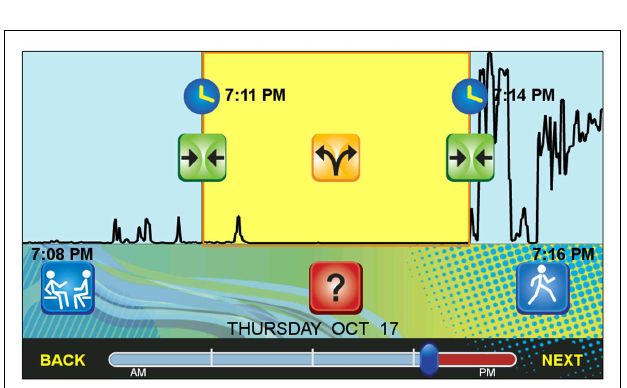
FIGURE 4 | Screenshot of the user interface for the sensor-assisted end-of-day recall .